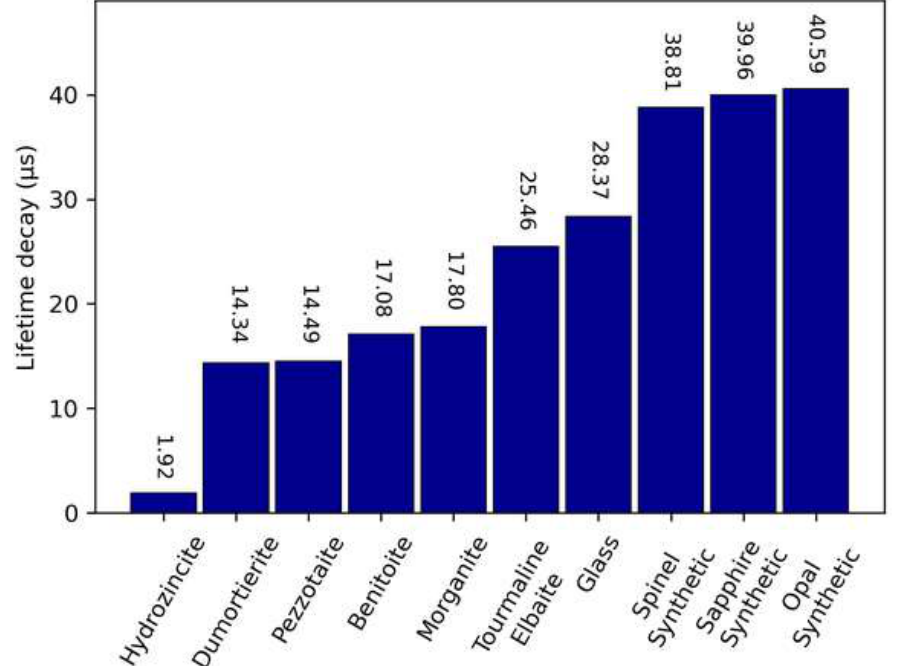
Figure 4. Lifetime decay of the ten samples showing BSL.